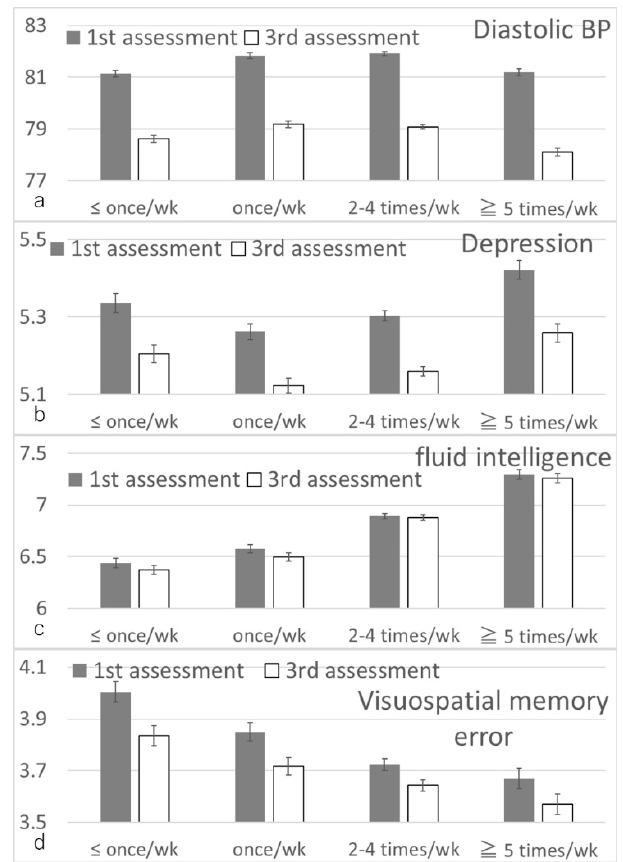
Figure 5. Associations of baseline cheese intake with subsequent changes in diastolic BP and cognitive measures. Bars represent raw unadjusted pre- and post-test values and error bars represent the standard error of the mean. ( a ) Diastolic BP. ( b ) Depression score. ( c ) Fluid intelligence. ( d ) Visuospatial memory errors. Analyses of covariance (ANCOVAs) adjusting for confounding variables including pre-test values showed that a greater cheese intake was associated with a greater diastolic BP decline, greater depression score increase, relatively increased fluid intelligence, and relatively decreased visuospatial memory errors ( p < 0.05, corrected for